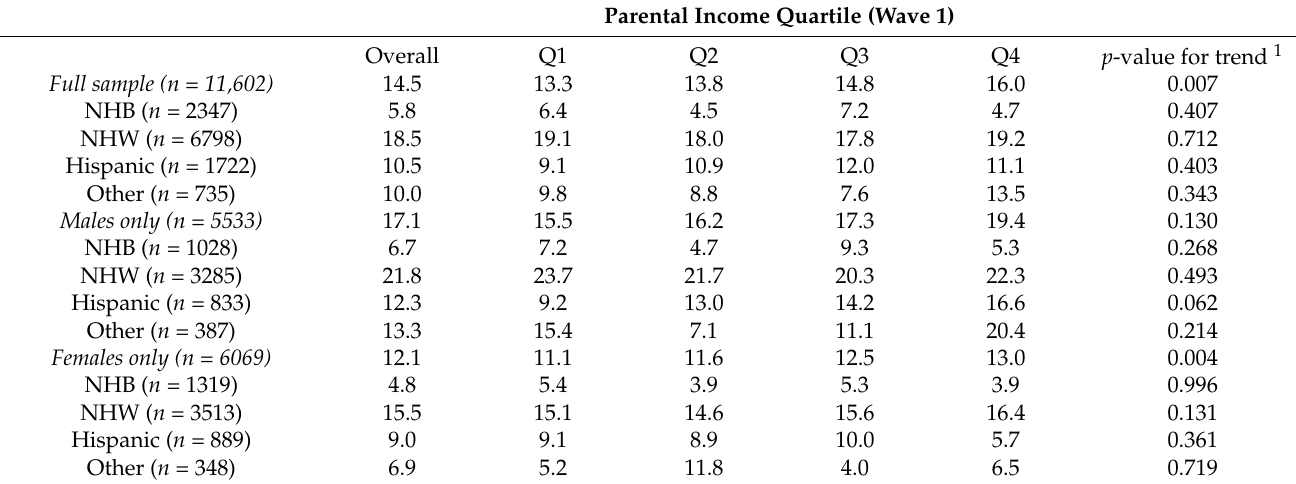
Table 3. Adjusted prevalence (%) reporting prescription painkiller misuse at Wave 4 ( n = 11,602).